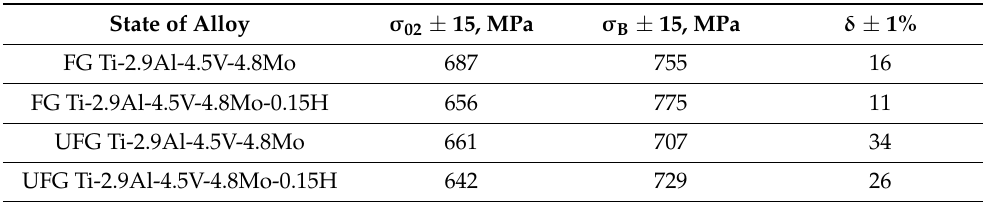
Table 2. Mechanical properties of the Ti-2.9Al-4.5V-4.8Mo and Ti-2.9Al-4.5V-4.8Mo-0.15H alloys at a temperature of 723